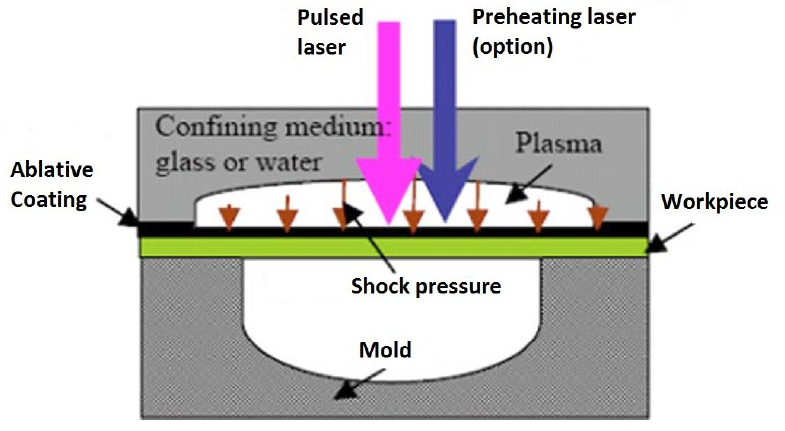
Figure 26. Schematic setup of the laser dynamic forming process